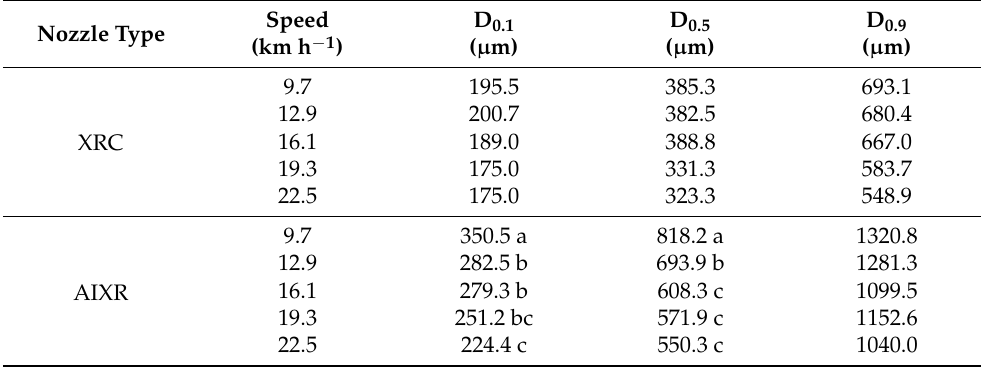
Table 8. Influence of ground speed on D 0.1 , D 0.5 , and D 0.9 by nozzle type for SRC. D 0.1 , D 0.5 , and D 0.9 are the droplet diameters (µm) where 10%, 50%, and 90%, respectively, of the spray volume is contained in the spray droplets smaller than this value. SRC represents the sprayer equipped with a rate controller used in this study.